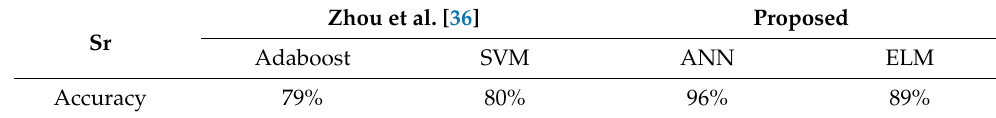
Table 7. Comparison of the proposed model with related work